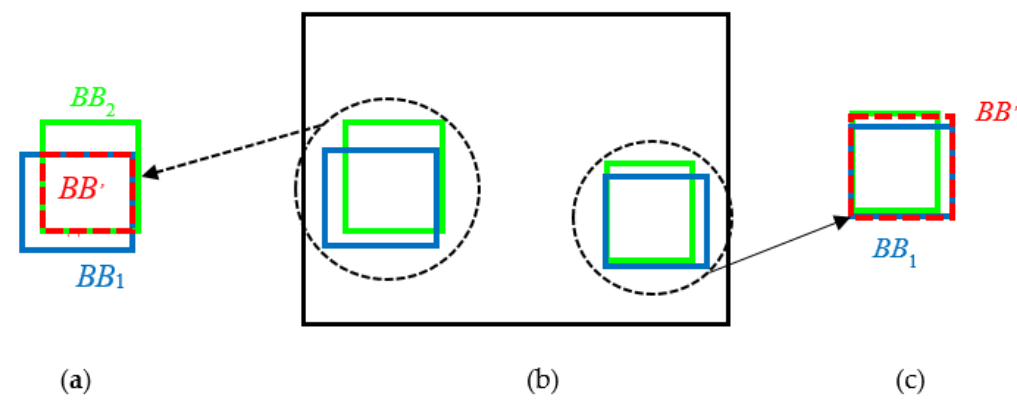
Figure 5. Decision-level fusion diagram of detection model. Blue area ( BB 1 ) is the model output from the depth image. Green area ( BB 2 ) is the model output from the color image. Red area ( BB ’) is the final detection model. When r 12 = 0, the fusion process is shown in ( a ). The models not to be fused are shown in ( b ). When r 12 = 1, the fusion process is shown in ( c ).